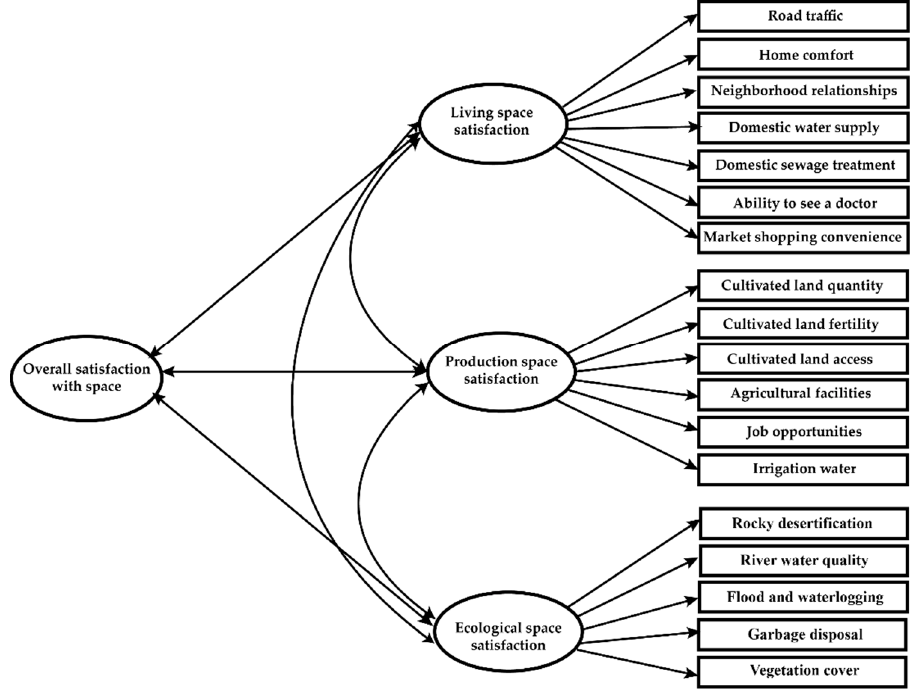
Figure 2. Model of the relationships between farmers’ satisfaction and their Ecological–Living– Productive